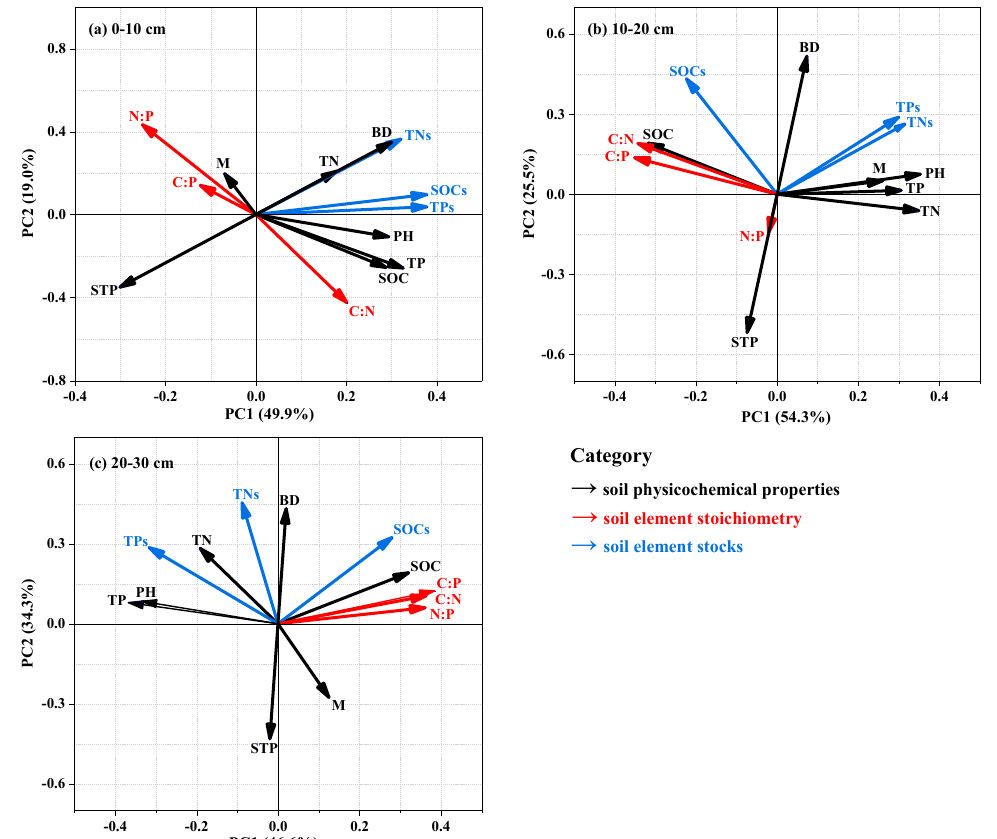
Figure 6. Principal component analysis (PCA) of soil physicochemical properties, element stocks, and their stoichiometry in the topsoil layer (0–10 cm) ( a ) and subsoil layers (10–20 and 20–30 cm) ( b , c ). Abbreviations: SOC, soil organic carbon; TN, total nitrogen; TP, total phosphorus; SOCs, soil organic carbon stocks; TNs, total nitrogen stocks; TPs, total phosphorus stocks; C:N, SOC–to–TN ratio; C:P, SOC–to–TP ratio; N:P, soil TN–to–TP ratio; M, soil moisture content; BD, soil bulk density; STP, soil total porosity.